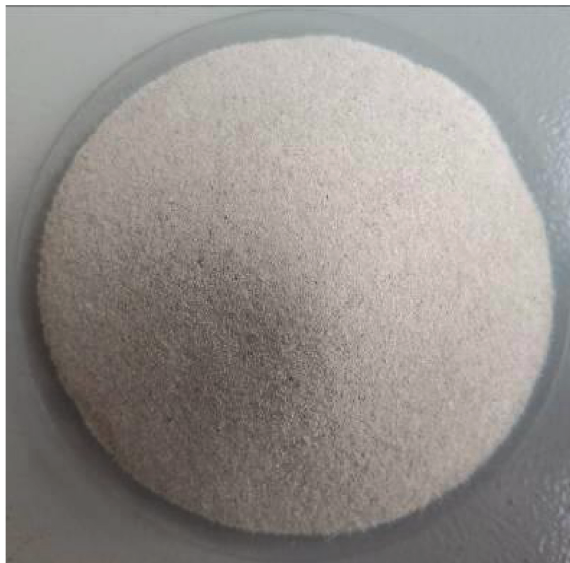
Figure 4: Sand used in the test. Table 1: Physical and mechanical properties of sand.